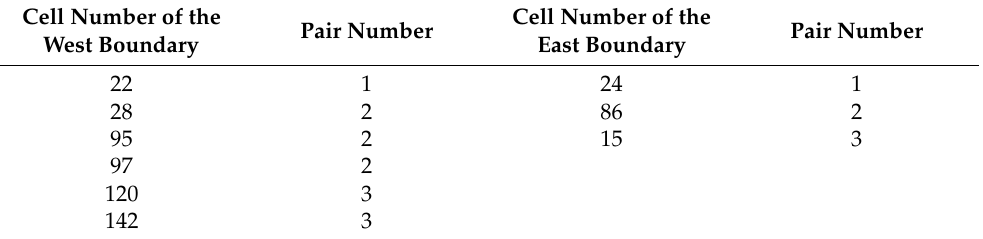
Figure 6. An example of periodic boundary condition. Table 2. Periodic pair number table. Table 2. Periodic pair number table.